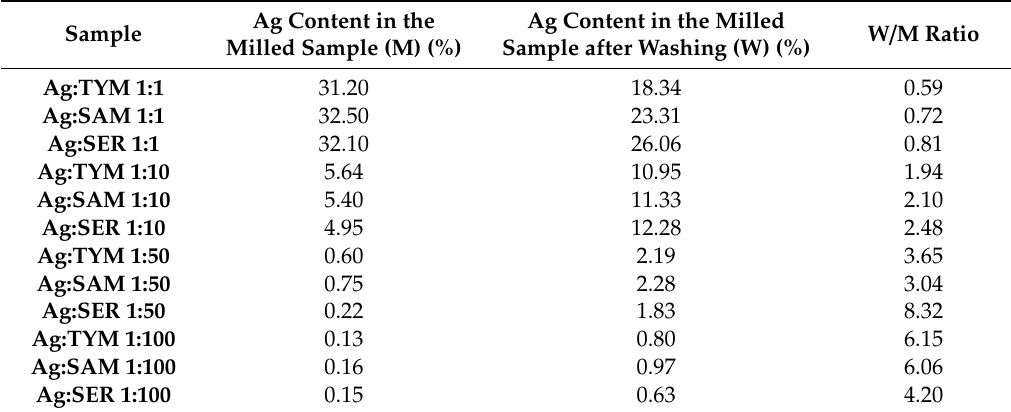
Table 4. Ag content in the solid samples obtained after milling and also after subsequent washing determined using atomic absorption